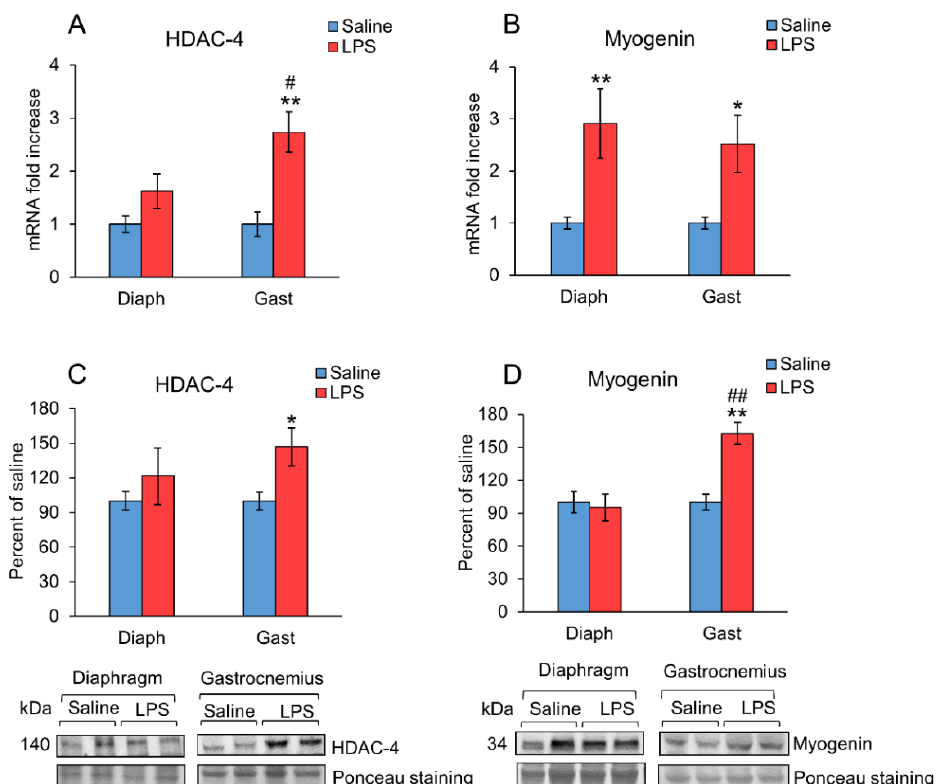
Figure 5. Effect of sepsis induced by LPS injection (10 mg/kg ip.) on ( A ) HDAC-4 and ( B ) Myogenin mRNA, ( C ) HDAC-4, and ( D ) Myogenin in rat diaphragm and gastrocnemius muscles, 24 h after a single injection of LPS or saline solution. mRNA was measured by PCR and proteins by Western blot. Representative Western blots are shown in ( C , D (bottom)). The data represent mean ± standard error of the mean (SEM) for n = 6–8 rats/group. * p < 0.05 and ** p < 0.01 versus their respective control rats treated with saline, # p < 0.05 and ## p < 0.01 versus diaphragm of rats treated with LPS. Diaph: diaphragm, Gast: gastrocnemius.